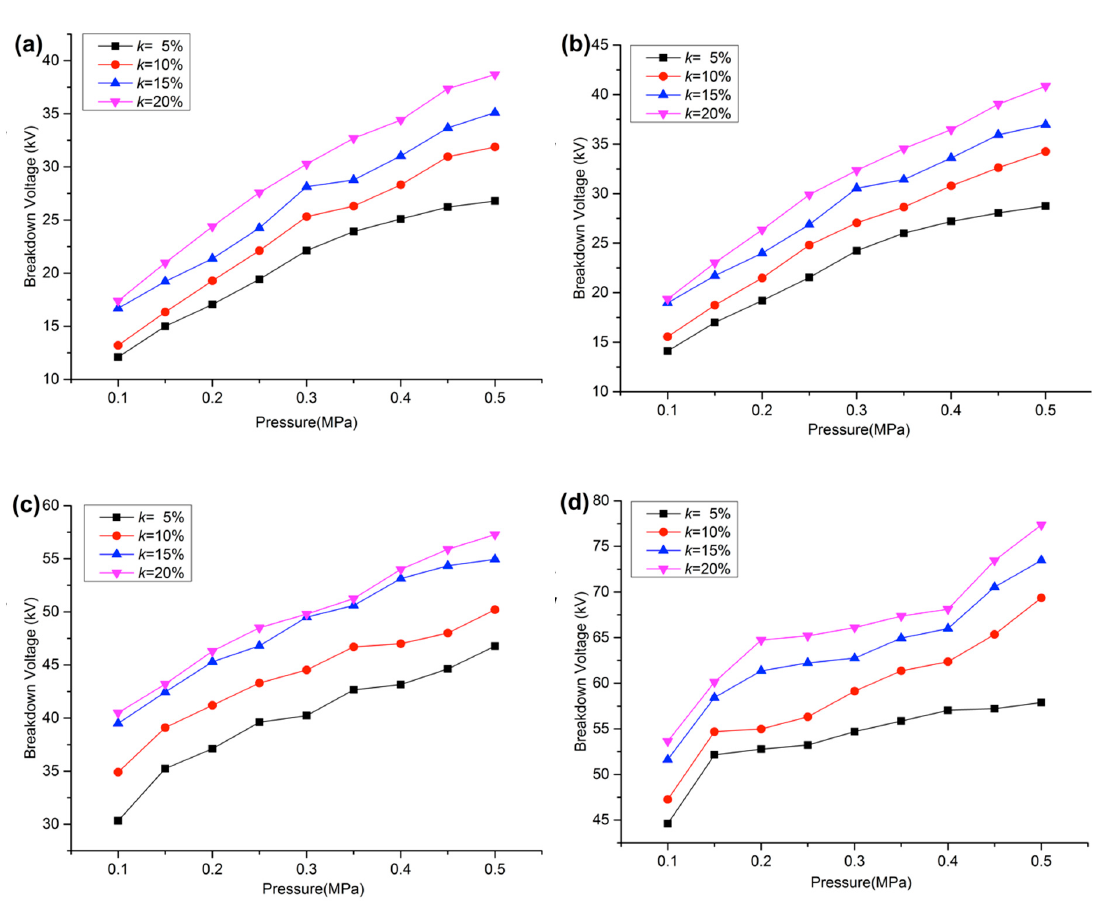
Figure 4. The breakdown voltages of the mixture varying with pressure: electrode distance d of ( a ) 5, ( b ) 10, ( c ) 15, and ( d ) 20 mm. 143